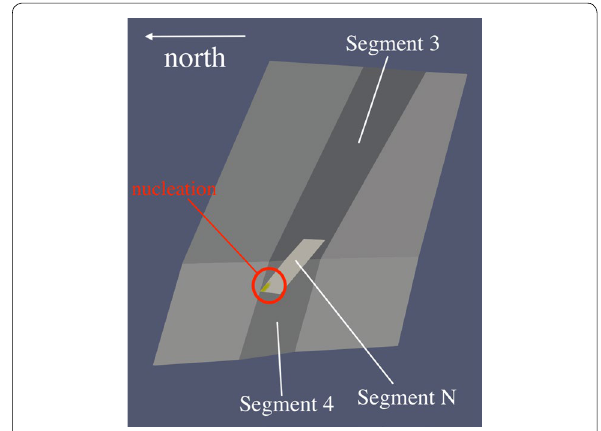
Fig. 3 The fault geometry of Case B with Segment N and the nucleation location. View from the